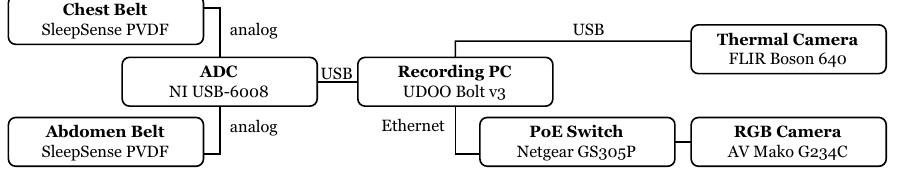
Figure 4. Diagram of the measurement setup.